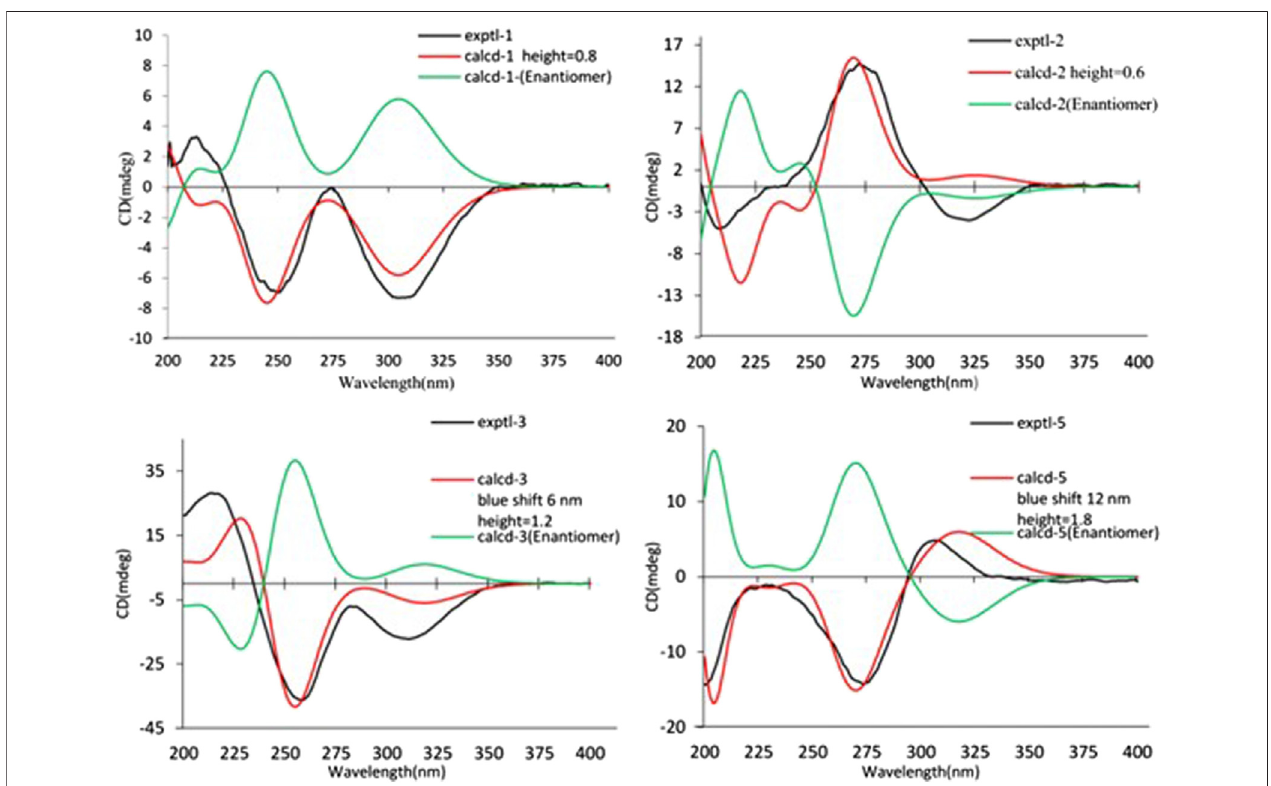
FIGURE 5 | Experimental and calculated ECD spectra of 1 – 3,